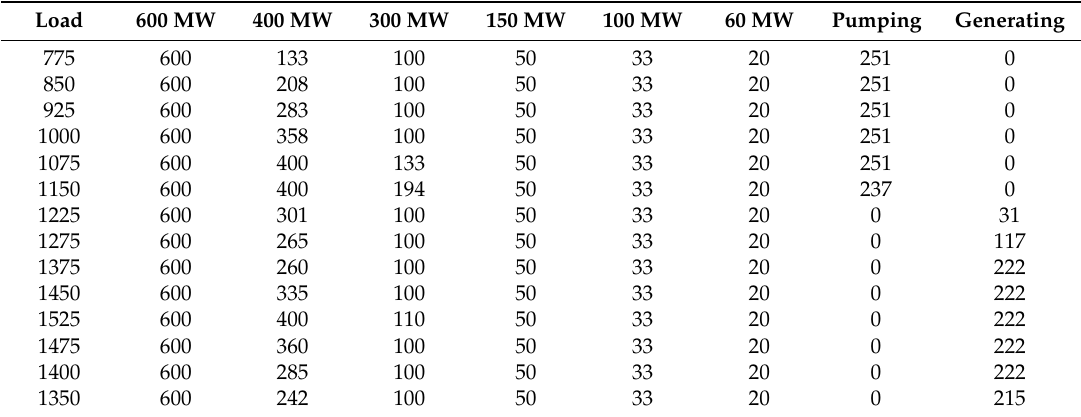
Table A1. The results of proposed dispatching optimization